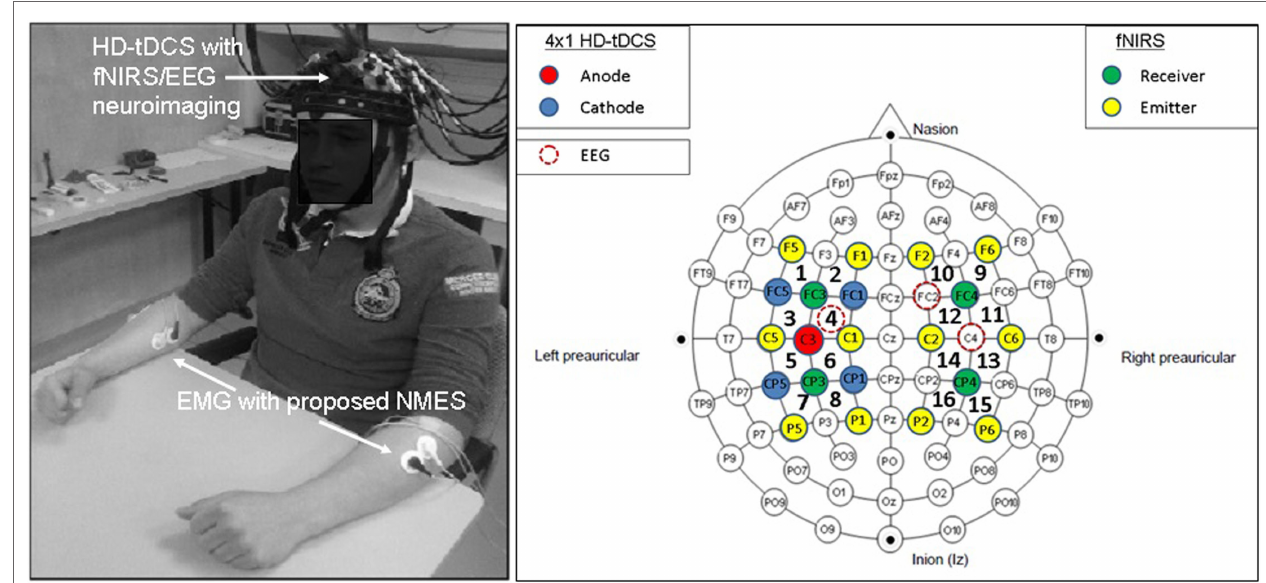
FiGUre 1 | electroencephalography (eeG)-functional near-infrared spectroscopy (fnirs) joint-imaging during non-invasive brain stimulation (niBs) and neuromuscular electrical stimulation (nMes) . Left panel: experimental setup for the upper limb, Right panel: EEG–fNIRS sensor montage along with NIBS stimulation electrodes [from Ref. (20)]. Figure adapted from Dutta et al.